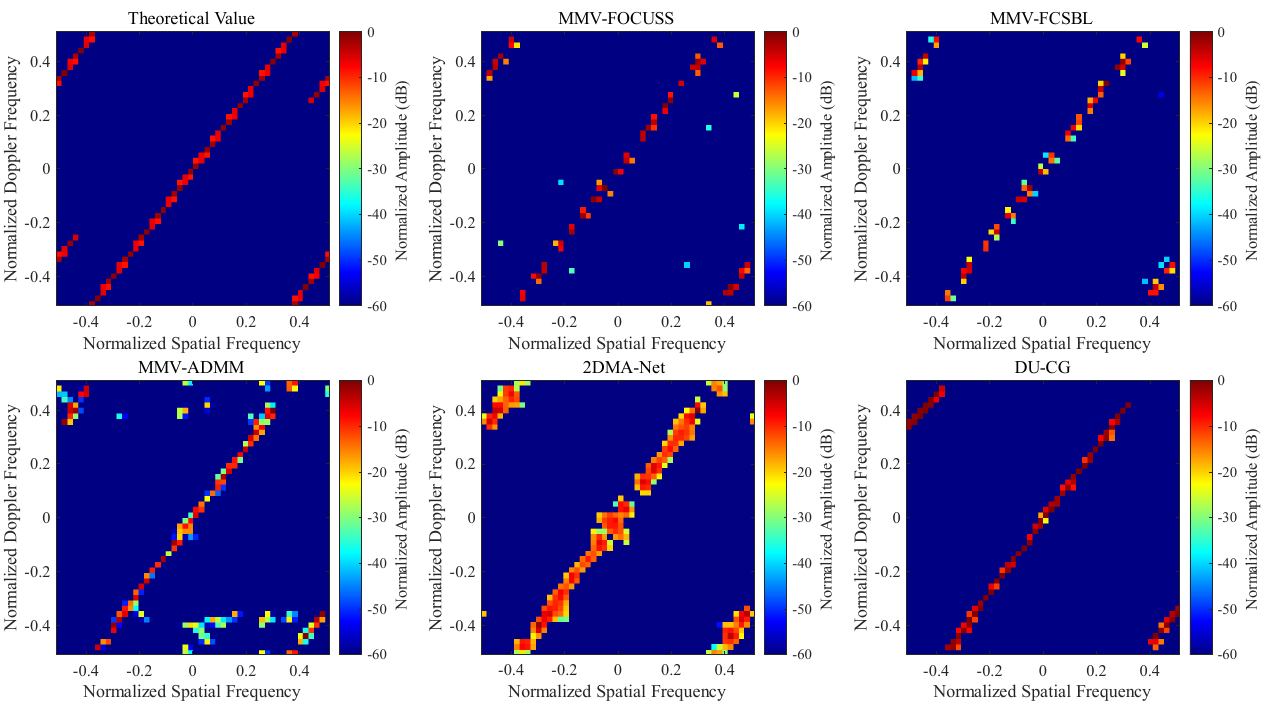
Figure 9. Clutter spectrum estimation results obtained using different methods in the non-ideal case with the clutter ridge slope as 1.34.